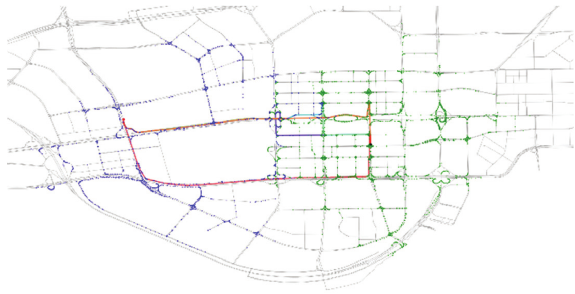
Figure 5: Charging path planning by